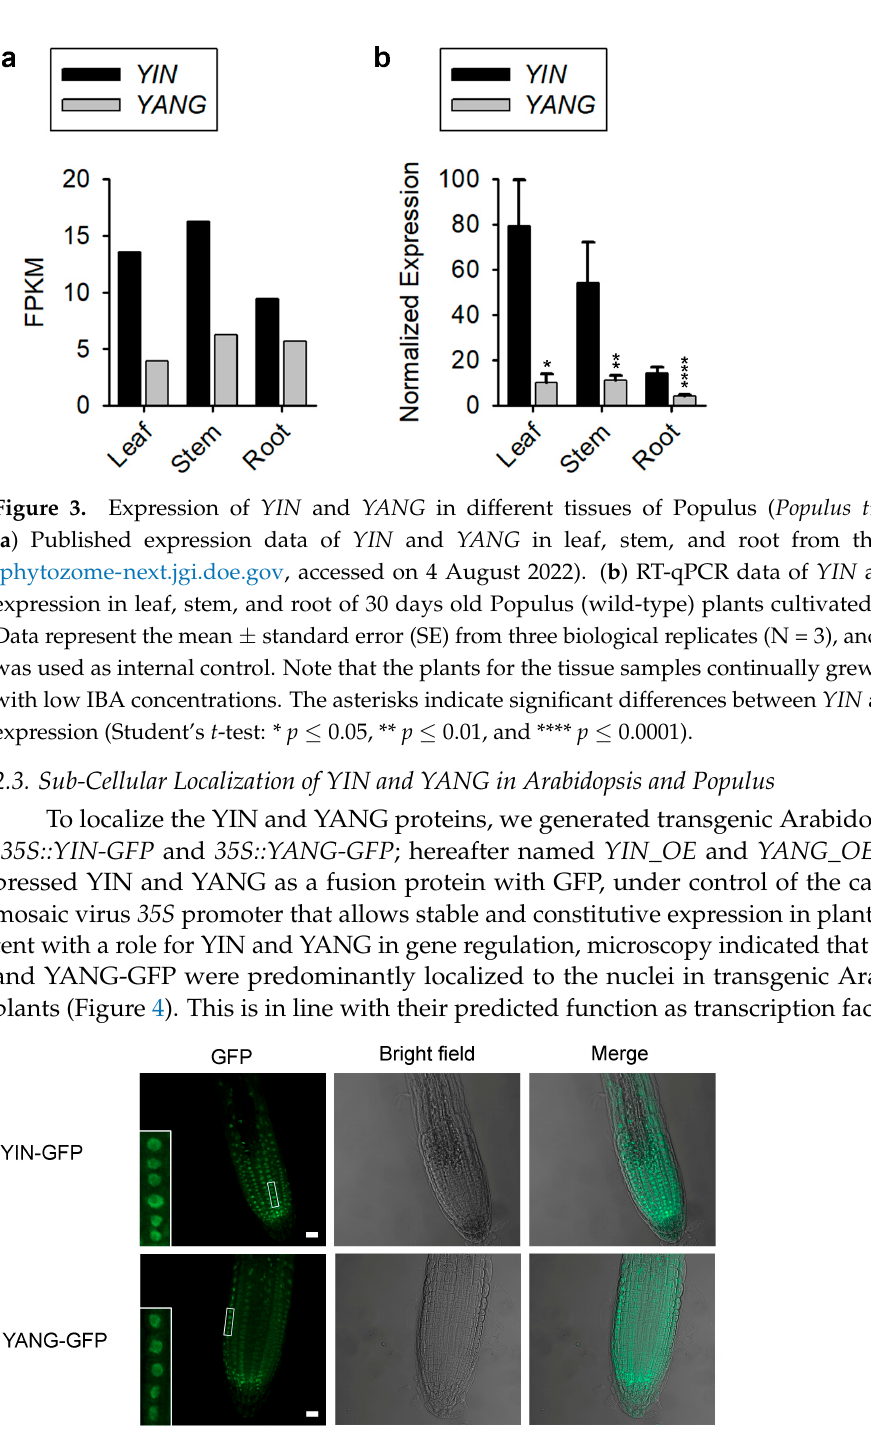
Figure 4. Subcellular localization of YIN-GFP and YANG-GFP fusion proteins in Arabidopsis. Stable transgenic expression of the YIN-GFP and YANG-GFP fusion proteins in Arabidopsis root cells. Note that both fusion proteins are mainly localized in the nuclei (see details in close-ups). Scale bars, 10 μ m.